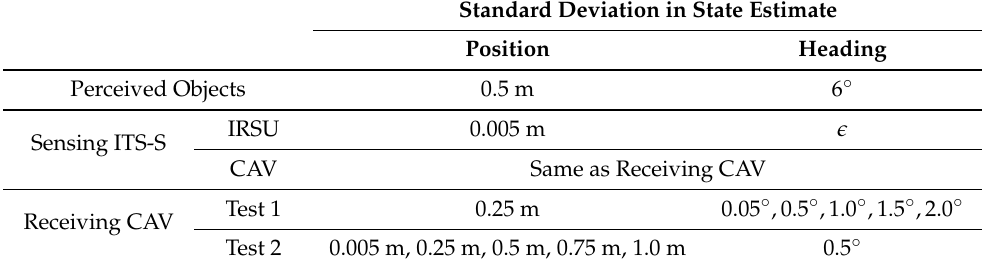
Table 1. Simulation